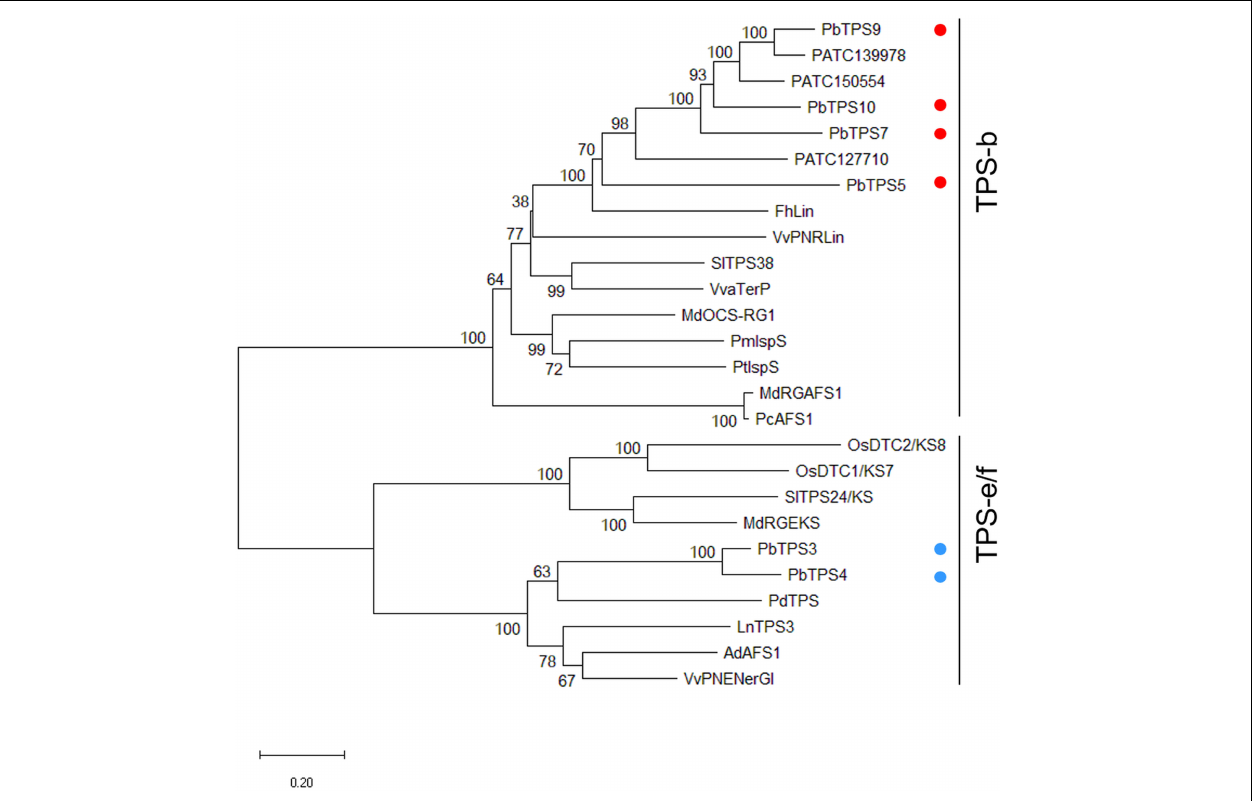
FIGURE 1 | Phylogenetic analysis of PbTPS3 , PbTPS4 , PbTPS5 , PbTPS7 , PbTPS9 , PbTPS10 , and other plant TPSs. The coding sequence was used to construct a phylogenetic tree using the nearest neighbor-joining method with the Jones–Taylor–Thornton model and pairwise deletion with 1,000 bootstrap replicates by MEGA 7.0. The numbers at each node represent the bootstrap values. The MTPS of Phalaenopsis orchid are marked with red dots. PbTPS5 , PbTPS7 , PbTPS9 , and PbTPS10 are grouped in the TPS-b subfamily and labeled in red dots. PbTPS3 and PbTPS4 are grouped in the TPS-e/f subfamily and labeled in blue dots. Information on TPS genes used for phylogenetic analysis is in Supplementary Table 1